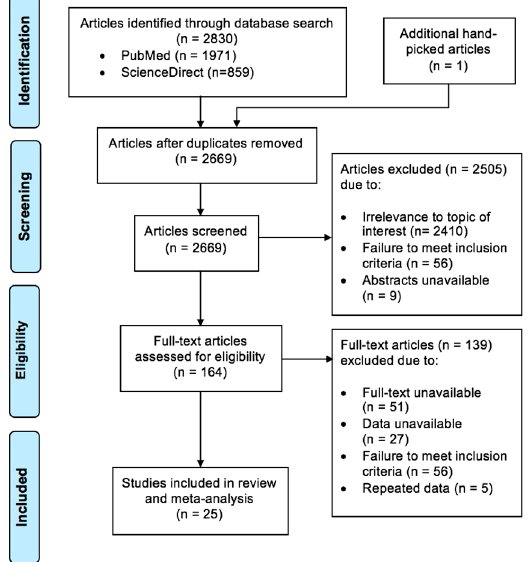
Figure 1. Process of systematic selection using the Preferred Reporting Items for Systematic Reviews and Meta-Analyses (PRISMA) flow chart.